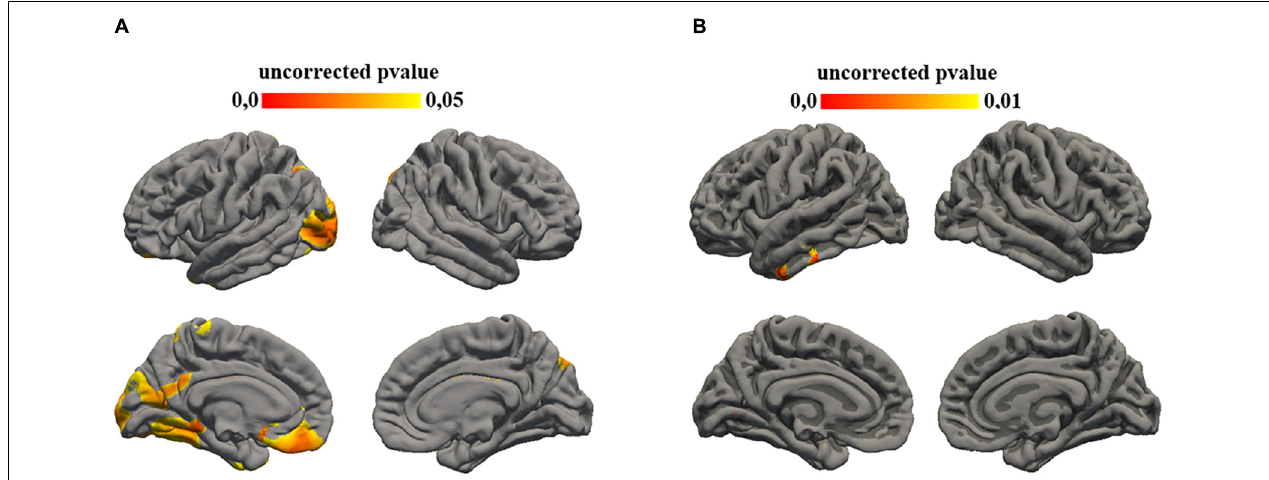
FIGURE 5 | Statistical results mapped on the surface template. (A) Uncorrected p -value maps for cortical thickness-ADOS_total score correlation. Significance was set at 0.05. (B) Uncorrected p -value maps for gyrification-ADOS-total score correlation. Significance was set at 0.01.